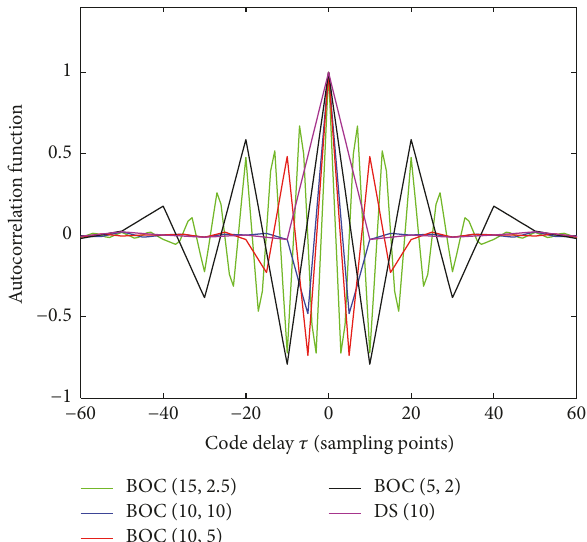
Figure 2: Autocorrelation function of the BOC sequence.